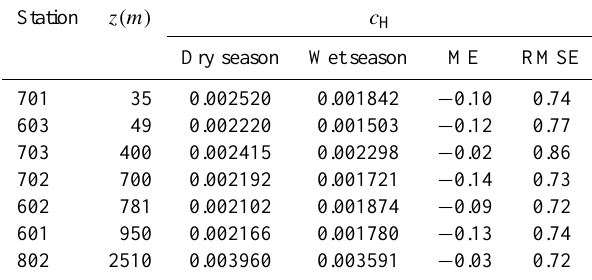
Table 5. Mean error (ME – mmday − 1 ) and root mean